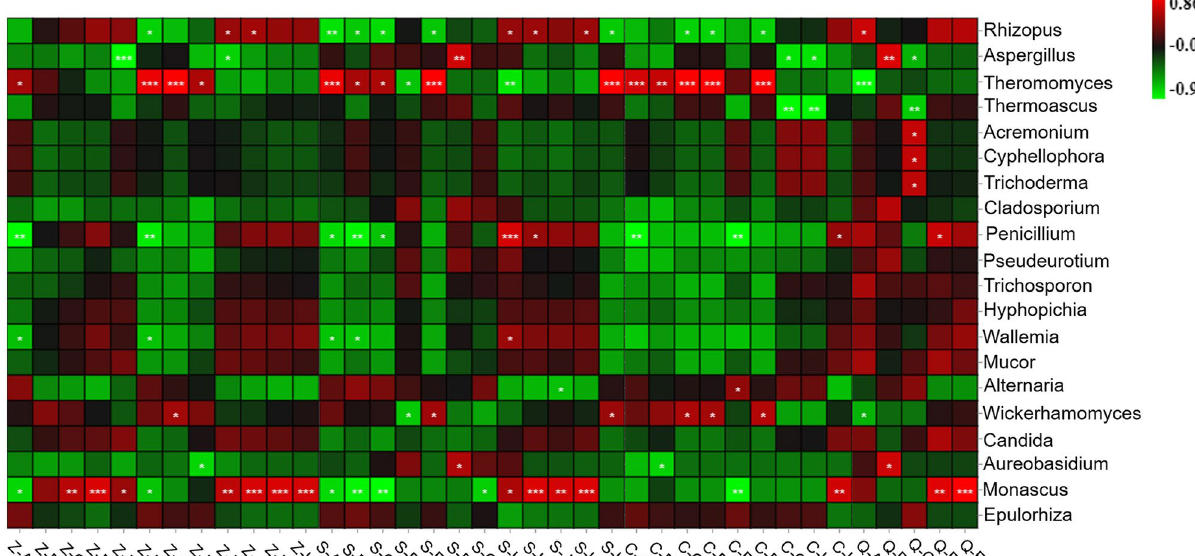
Figure 7. Heatmap showing the correlation between fungi and the main volatile compounds in pit mud. Note : Z-A, ethyl 2-hydroxypropionate; Z-B, butyl caproate; Z-C, ethyl caprylate; Z-D, hexyl hexanoate; Z-E, ethyl caprate; Z-F, ethyl phenylacetate; Z-G, ethyl 3-phenylpropionate; Z-H, ethyl hexadecanoate; Z-I, ethyl caproate; Z-J, ethyl heptanoate; Z-K, heptyl acetate; Z-L, N-hexyl caprylate; C-A, 1-hexanol; C-B, 1-octanol; C-C, 6-hendecanol; C-D, benzyl alcohol; C-E, phenethyl alcohol; C-F, triethylene glycol; C-G, 1-butanol C-H, 3-methyl-1-butanol C-I, 1-decyl alcohol; S-A, 2-methylpropionic acid; S-B, acetic acid; S-C, butyric acid; S-D, 3-methylbutyric acid; S-E, 3-methylpentanoic acid; S-F, valeric acid; S-G, caproic acid; S-H, heptanoic acid; S-I, Octanoic acid; S-J, nonanoic acid; S-K, capric acid; S-L, palmitic acid; Q-A, phenol; Q-B, p-methylphenol; Q-C, cresol; Q-D: 3-methylphenol; Q-E,